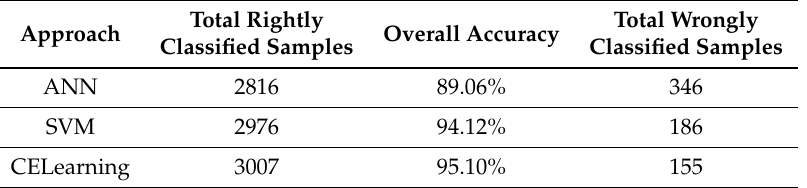
Table 7. Comparison of different methods for 12 categories of